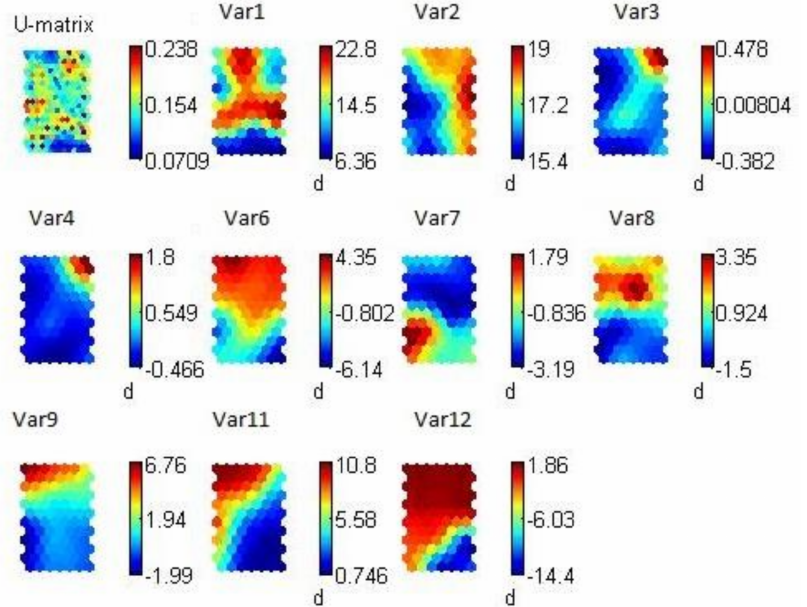
Figure 3. Map of features (The scale of values next to each map shows the rank of values which are taken by the representative patterns of all the mutual funds located in one